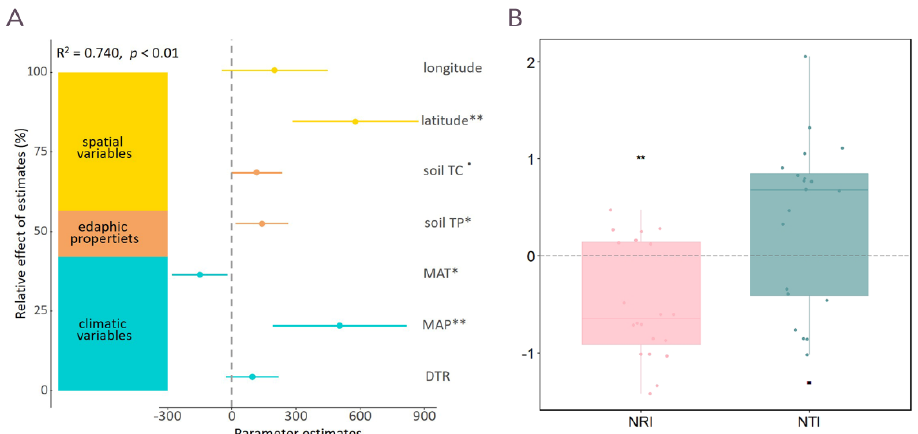
Figure 4. Effect of geospatial and environmental predictors on the phylogenetic diversity (Faith’s PD) ( A , see Figure 3 for interpretation) and the Net Relatedness Index (NRI) and the Nearest Taxon Index (NTI) values are expressed as boxplot ( B ). The p value of each predictor is given as: ** p < 0.01, * p < 0.05, · 0.05 < p < 0.1. Significant differences between mean NRI and NTI values from zero are indicated as: ** p < 0.01, · 0.05 < p <